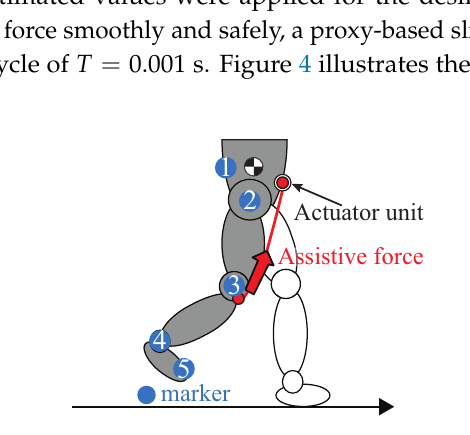
Figure 2. Assistance strategy for hip flexion. Blue-filled circles express reflective markers attached to the subjects in the experiment of Section 3 (1. approximation of the center of mass, 2. hip, 3. knee, 4. ankle, and 5.